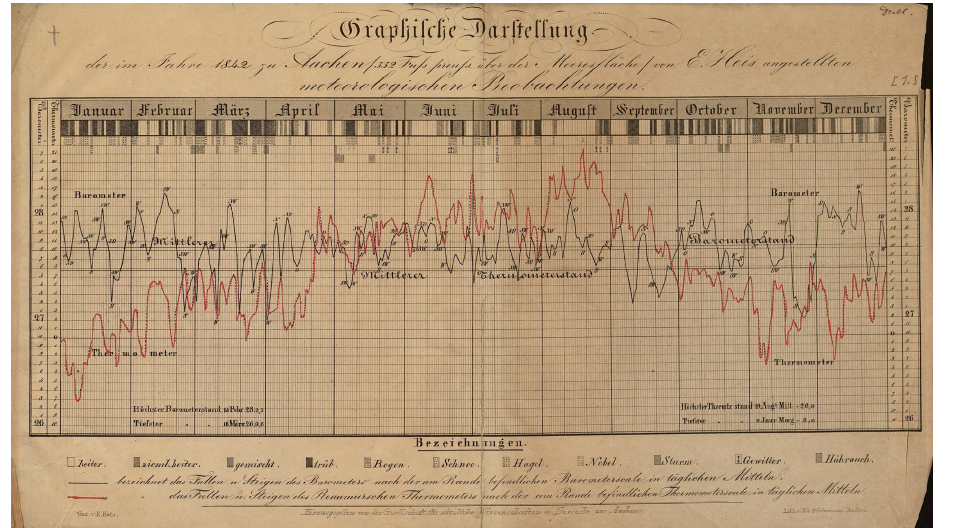
Figure 2. Weather observations in Aachen in 1842 done by Heis. (Digital Collection of the Universitäts- und Landesbibliothek Münster; urn:nbn:de:hbz:6:1-244588. Creative Commons – Public Domain Mark